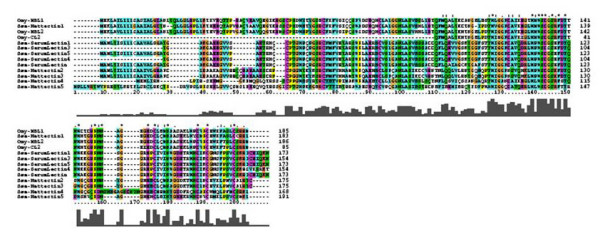
Alignment of rainbow trout and Atlantic salmon lectins. Sequence information includes the Genbank accession number; species is indicated as Omy for Oncorhynchus mykiss and Ssa for Salmo salar. Omy185132516 is encoded by the transcript spotted on the microarray. The sequences were aligned with ClustalX. D. Alignment of the predicted complement component 1, Q subcomponent binding protein (C1QBP) from three fish species with the human ortholog; species is indicated as Omy for Oncorhynchus mykiss, Ssa for Salmo salar, Dr for Danio rerio and Hs stands for Homo sapiens. The sequences are available at the accession numbers: human DQ891331, salmon paralog 1, salmon paralog 2, trout paralog 1 and trout paralog 2. The sequences were aligned with ClustalX.